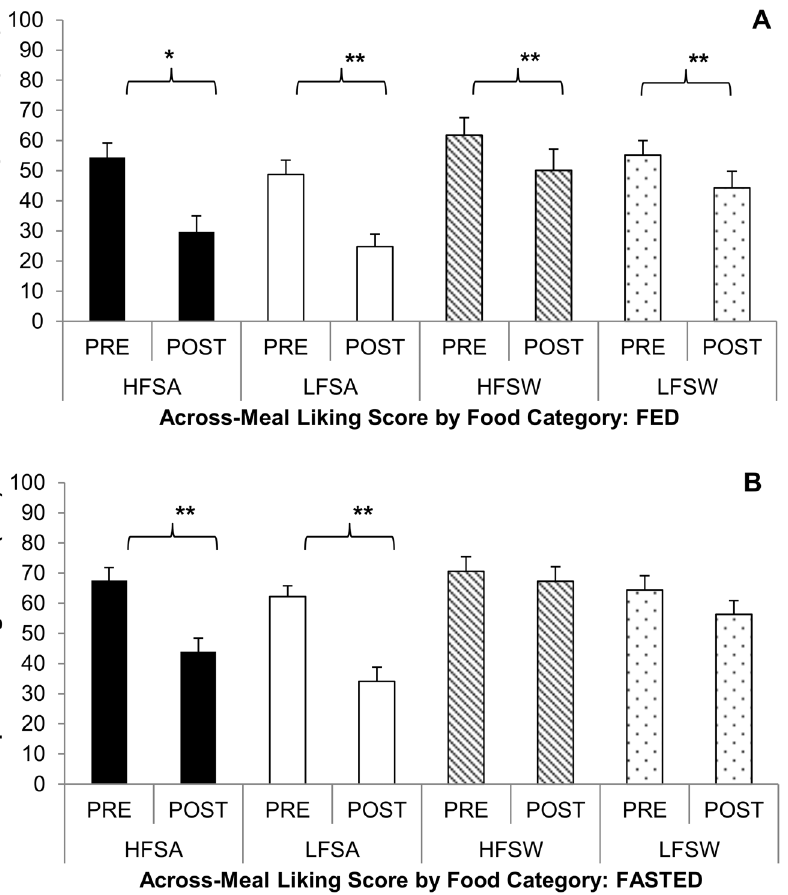
Figure 2. Results from the Leeds Food Preference Questionnaire for ‘liking’ of food images under FASTED and FED conditions. Showing the change in across-meal mean ‘liking’ score ( 6 SD) for each of the four food categories: high fat savory (HFSA), low fat savory (LFSA), high fat sweet (HFSW) and low fat sweet (LFSW). In the FED condition (panel A) across-meal ‘liking’ for all four categories decreased. Panel B demonstrates the contrast of hedonic ‘liking’ ratings in the experimental condition and suggests the absence of negative alliesthesia to food images of the sweet food category after completing a 24 hour fast. *p , 0.05, **p , 0.001.